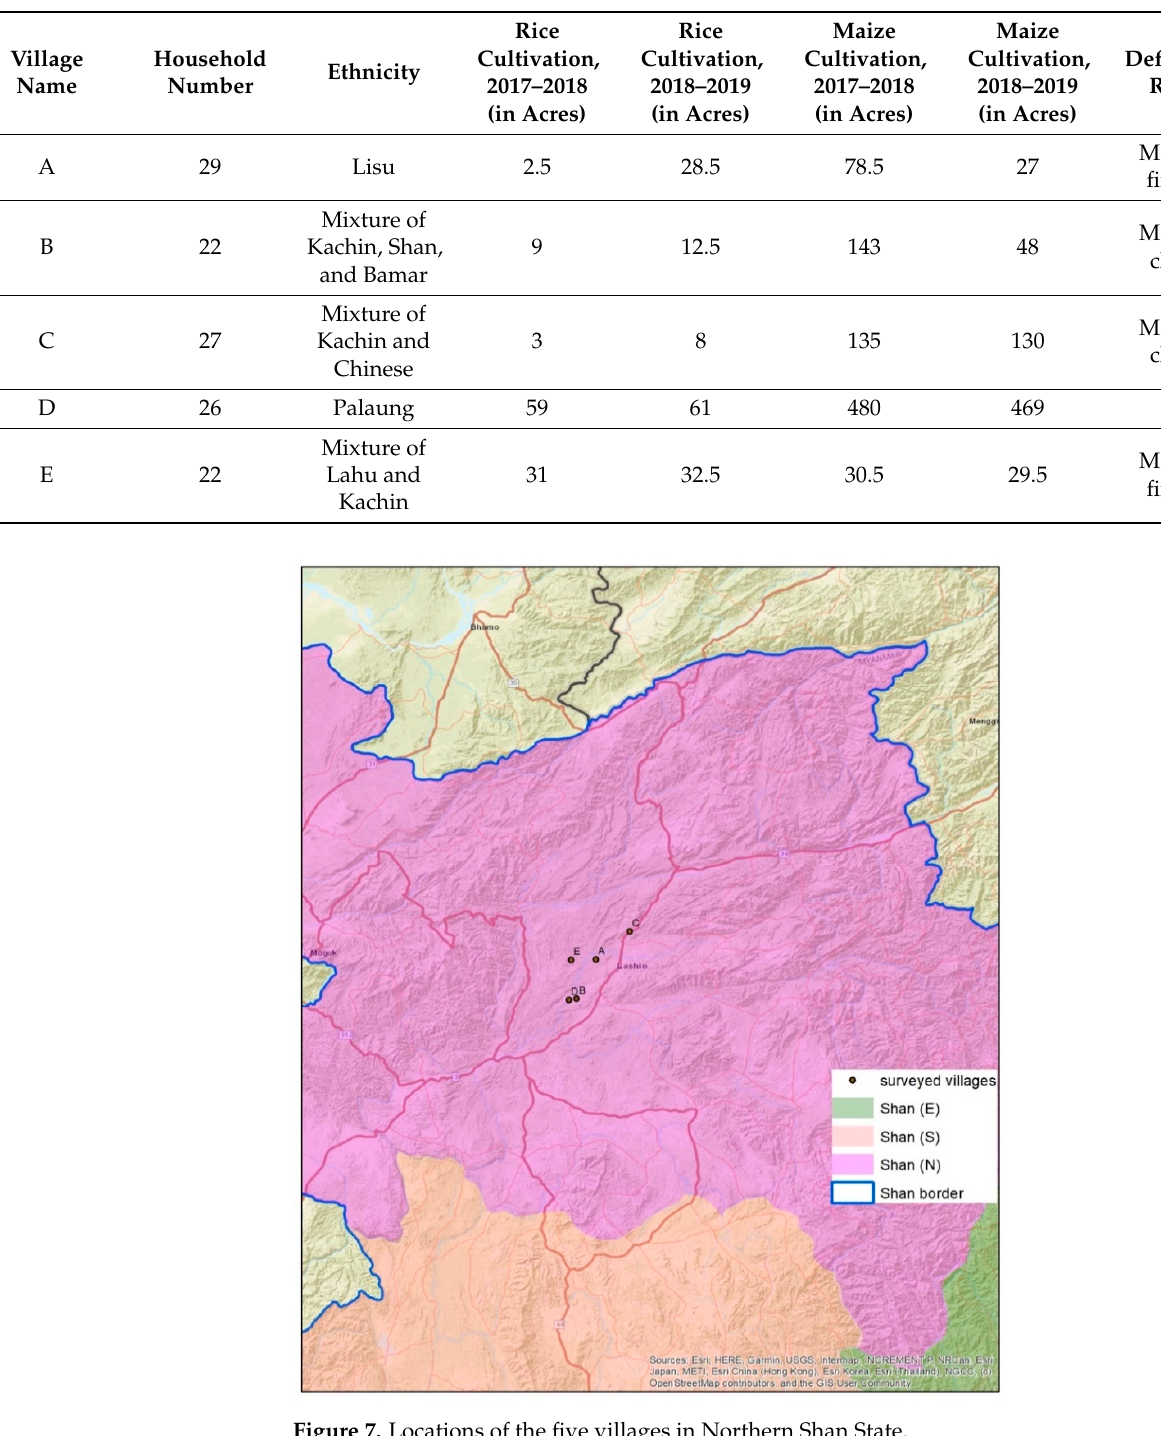
Figure 7. Locations of the five villages in Northern Shan State.